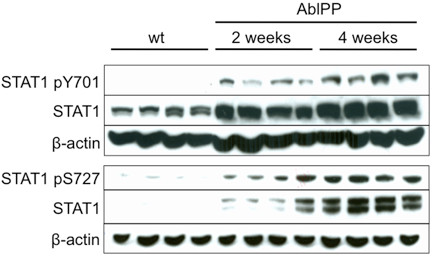
Levels of activated STAT1 are increased in AblPP/tTA mice 2 and 4 weeks off doxycycline. Western blot membranes were probed with antibodies to STAT1 pY701, STAT pS727, STAT1, and β-actin loading control. STAT1 pY701, STAT1 pS727, and STAT1 total protein levels were elevated in AblPP mice expressing constitutively active c-Abl for 2 and 4 weeks compared with wild-type controls.